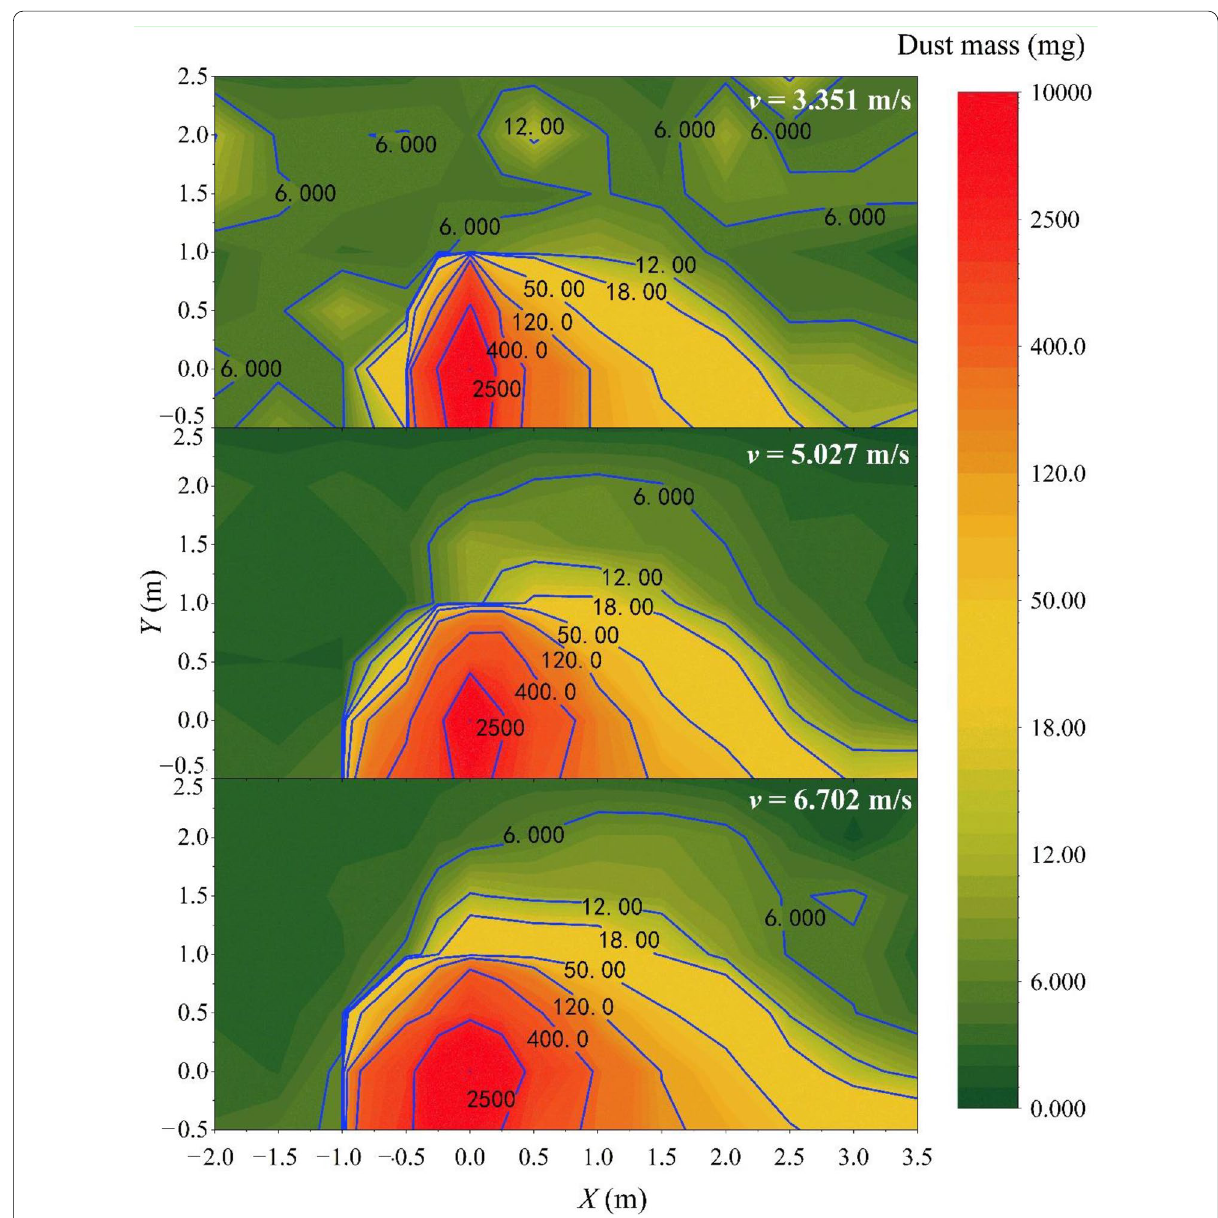
Fig. 4 The mass contour of dust particles collected from all sampling points at different cutting